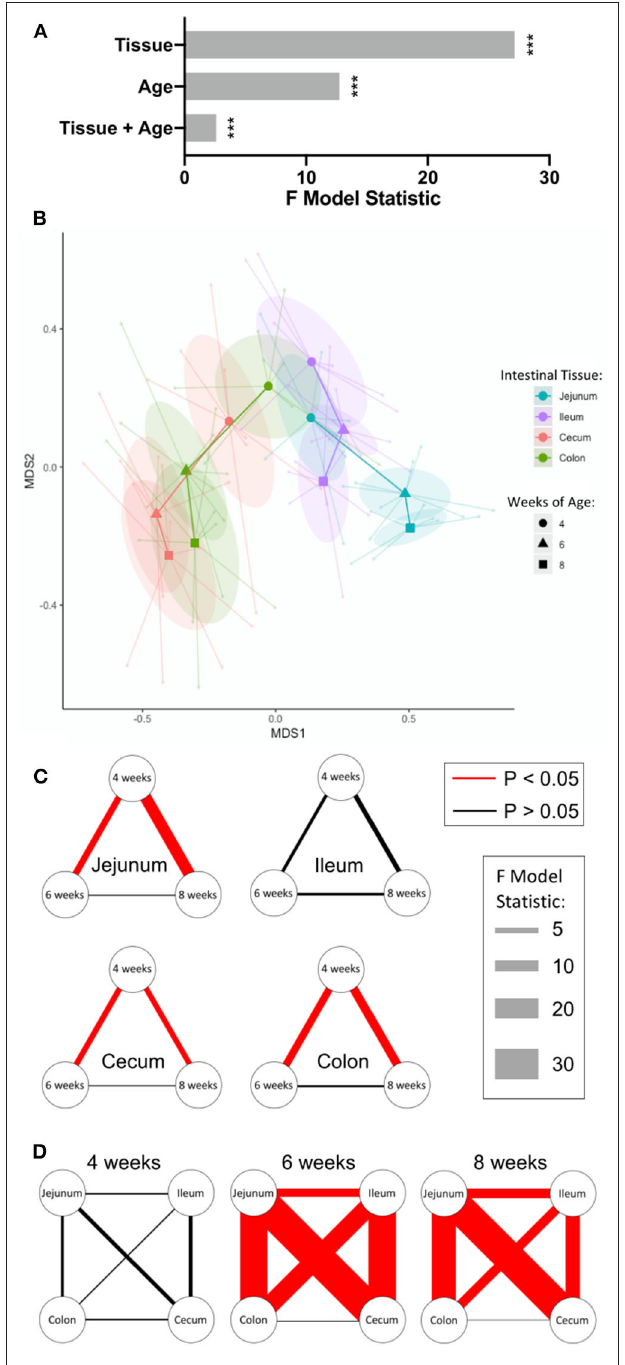
FIGURE 3 | IETs diverged by intestinal location over time. (A) Multivariate analysis of flow cytometry data to assess tissue- and age-dependent effects on compositions of IET communities. Sample frequencies of the 16 discrete cell subpopulations defined by flow cytometry gating of αβ or γδ T cell populations and CD27 expression were analyzed for their overall tissue and age-dependent effects using PERMANOVA analysis. Greater F model statistic values represent greater magnitude of differences, while p < 0.05 were considered significant (*** < 0.001). (B) NMDS visualization of IET communities based on sample frequencies of the 16 discrete cell subpopulations